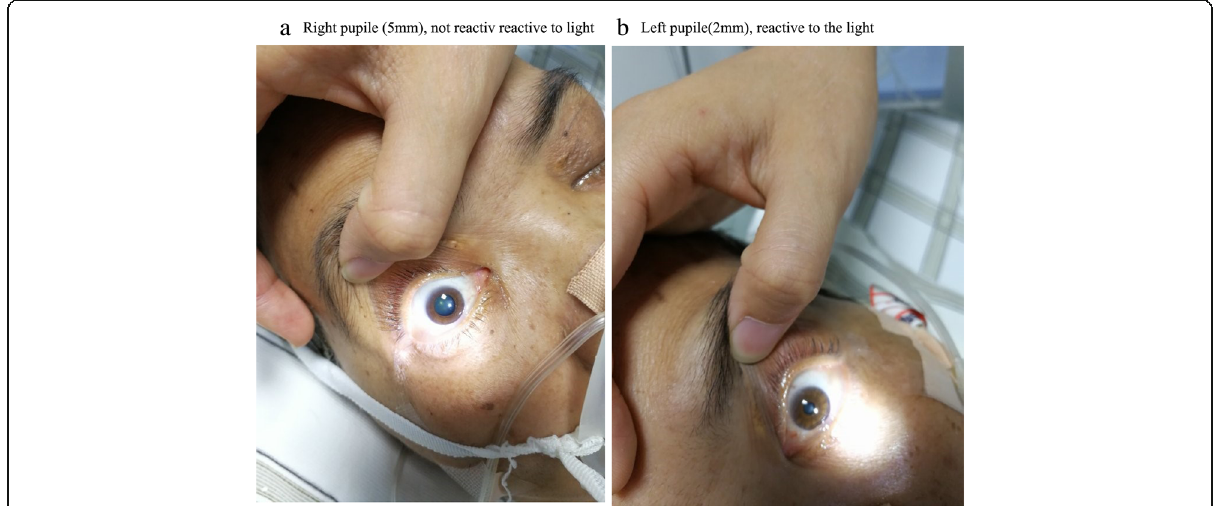
Fig. 5 The specific clinical presentation. The patient showed recurrent sweating profusely on the right forehead and the right pupil was enlarged to 5 cm with no reactivity to light for about 8 h. The left pupil was